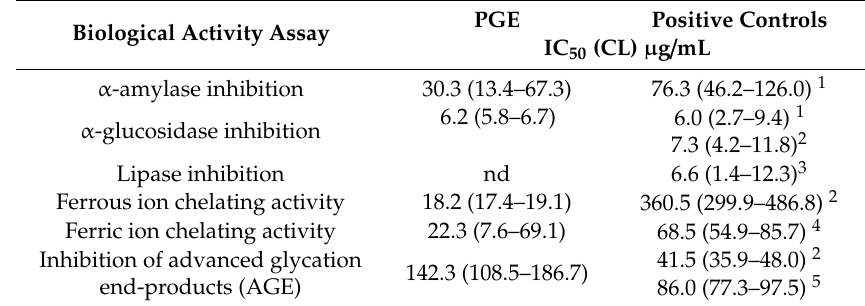
Table 3. IC 50 values of the ethyl acetate extract, obtained by Soxhlet from the waste peel of Punica granatum L. var. Dente di Cavallo DC2 (PGE), and the positive controls for enzyme inhibition, iron chelating activity, and inhibition of advanced glycation end-products